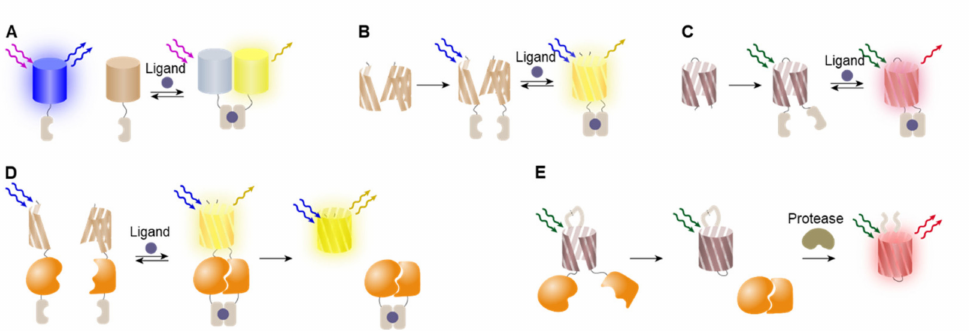
Figure 4. Reporting elements to fabricate cell-based sensors. ( A ) Cell-based sensor design based on FRET. ( B ) Cell-based sensor design based on BiFC. ( C ) Cell-based sensor design based on cpFP. ( D ) Intein application for BiFC with reconstitution of split FP. ( E ) The intein is applied to enhance FP